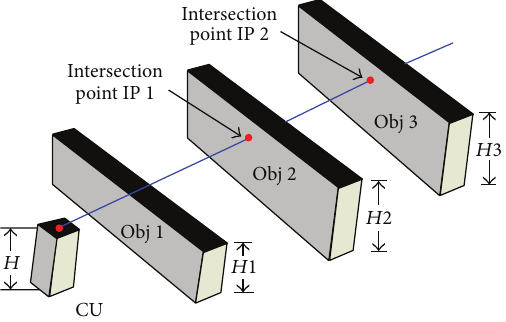
Figure 6: Closest intersection point detection.